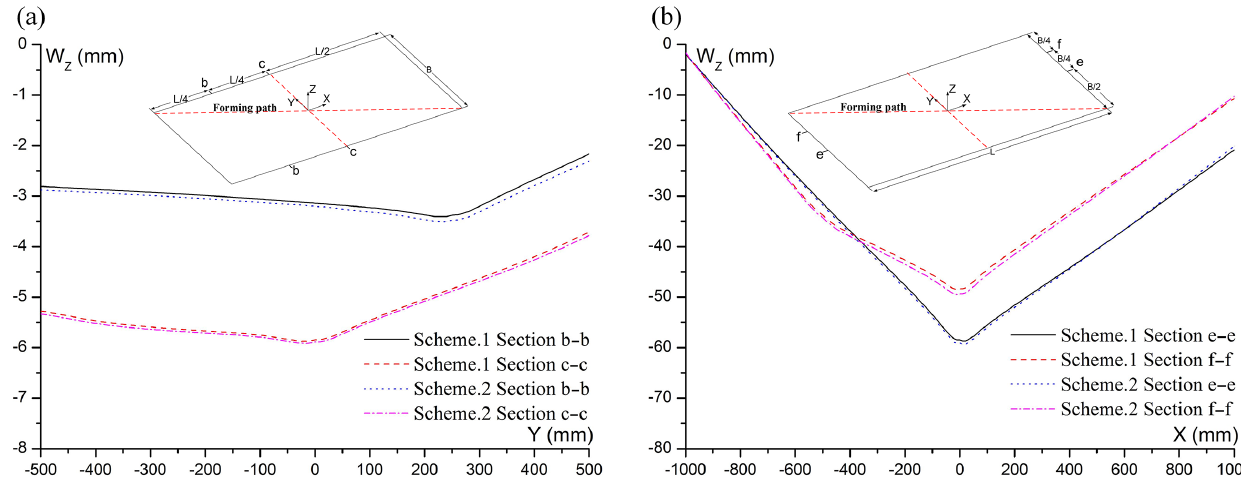
Figure 12. Results of deformation of different loading sequences. (a) Results from lateral sections. (b) Results from longitudinal sections.